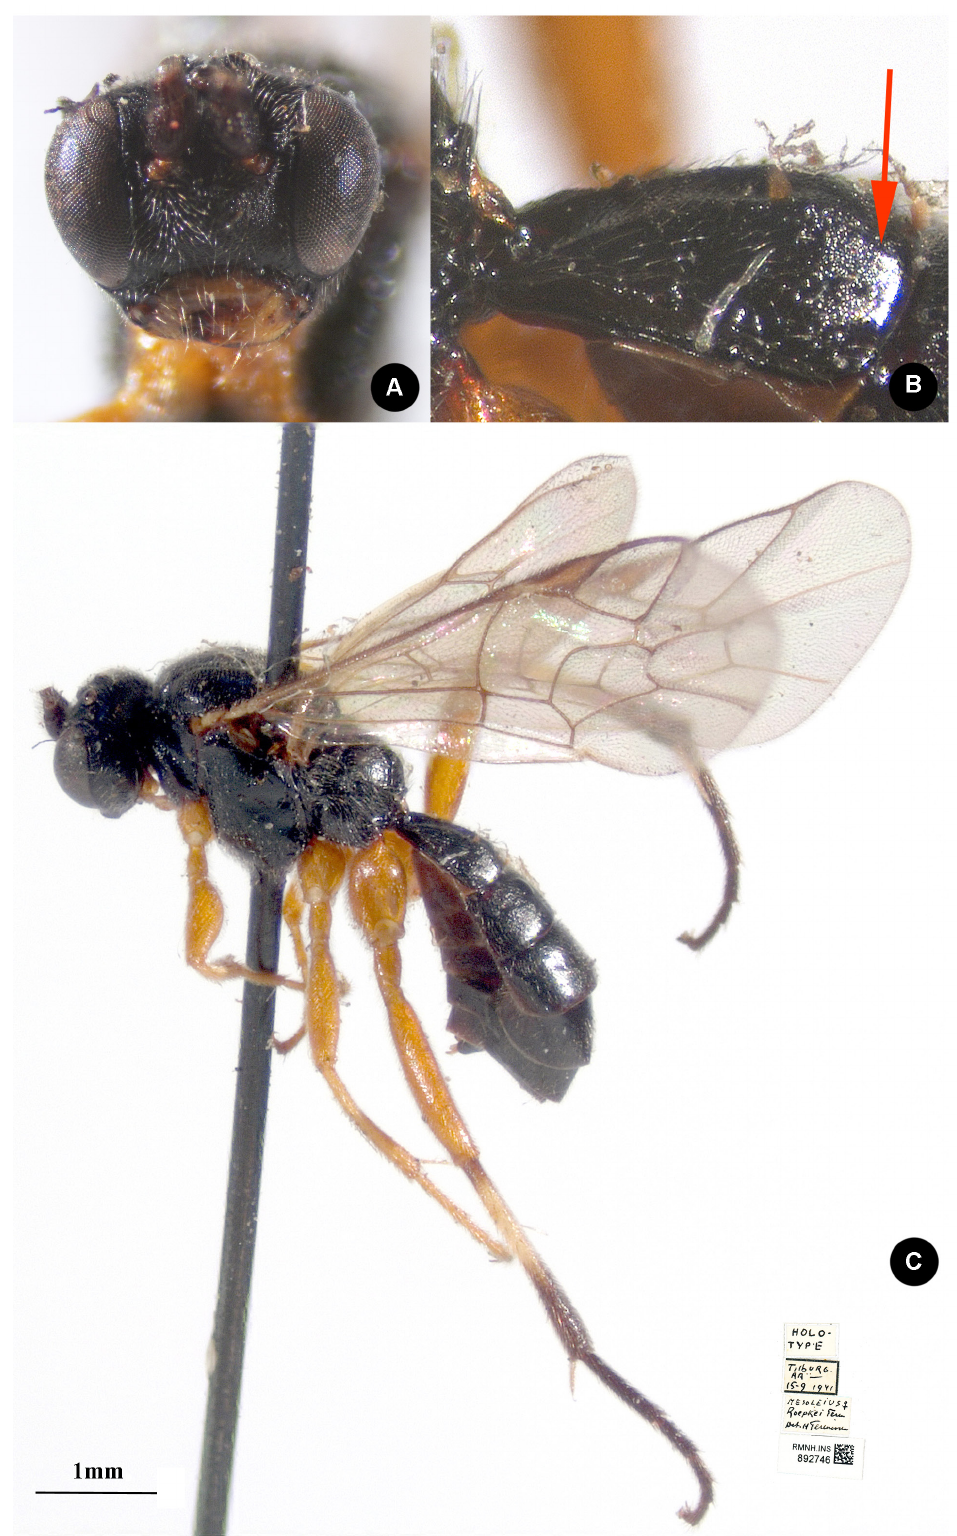
Fig. 2. Mesoleius roepkei Teunissen, 1945, holotype, ♀. A . Face. B . First metasomal tergite with shallow subapical transverse impressions (arrow). C .